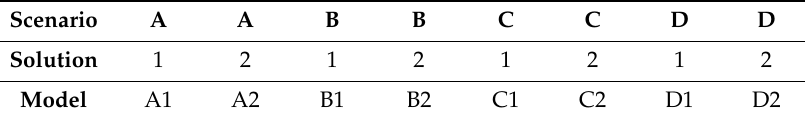
Table 3. Numerical model